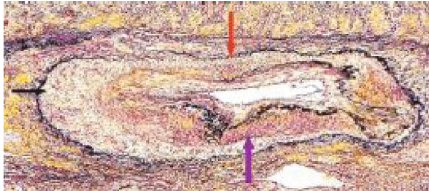
Figure 23: Segmental arterial mediolysis reparative phase showing evolution to FMD. The black arrow points to expanded tear space bordered by an intact external elastica fi lled with granulation tissue that extends upwardly at the red arrow to totally replace an irregular zone of lost medial muscle. The upper left internal elastica is missing, and the lumen is narrowed by a circumferential plaque of granulation tissue. The purple arrow points to a zone of intact media showing focal fi brosis. Movat stain × 25 (adapted with permission from Cardiovascular Pathology 18(6) copyright 2009 Elsevier Inc.).